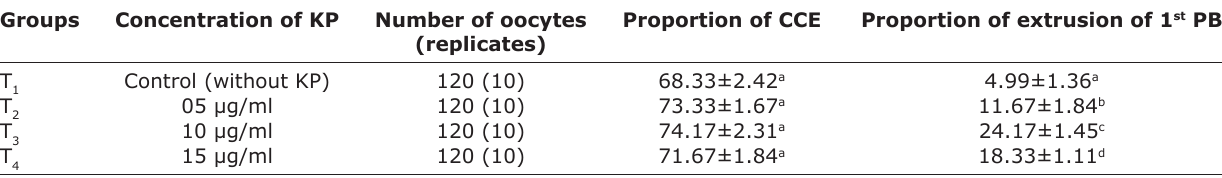
Table-2: Effect of different concentrations of KP on in vitro maturation of sheep oocytes. Groups